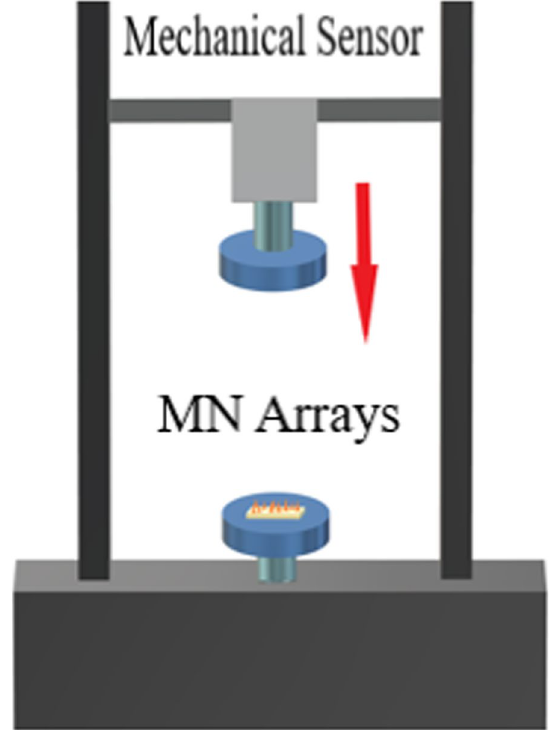
Fig. 4 Schematic of the mechanical test